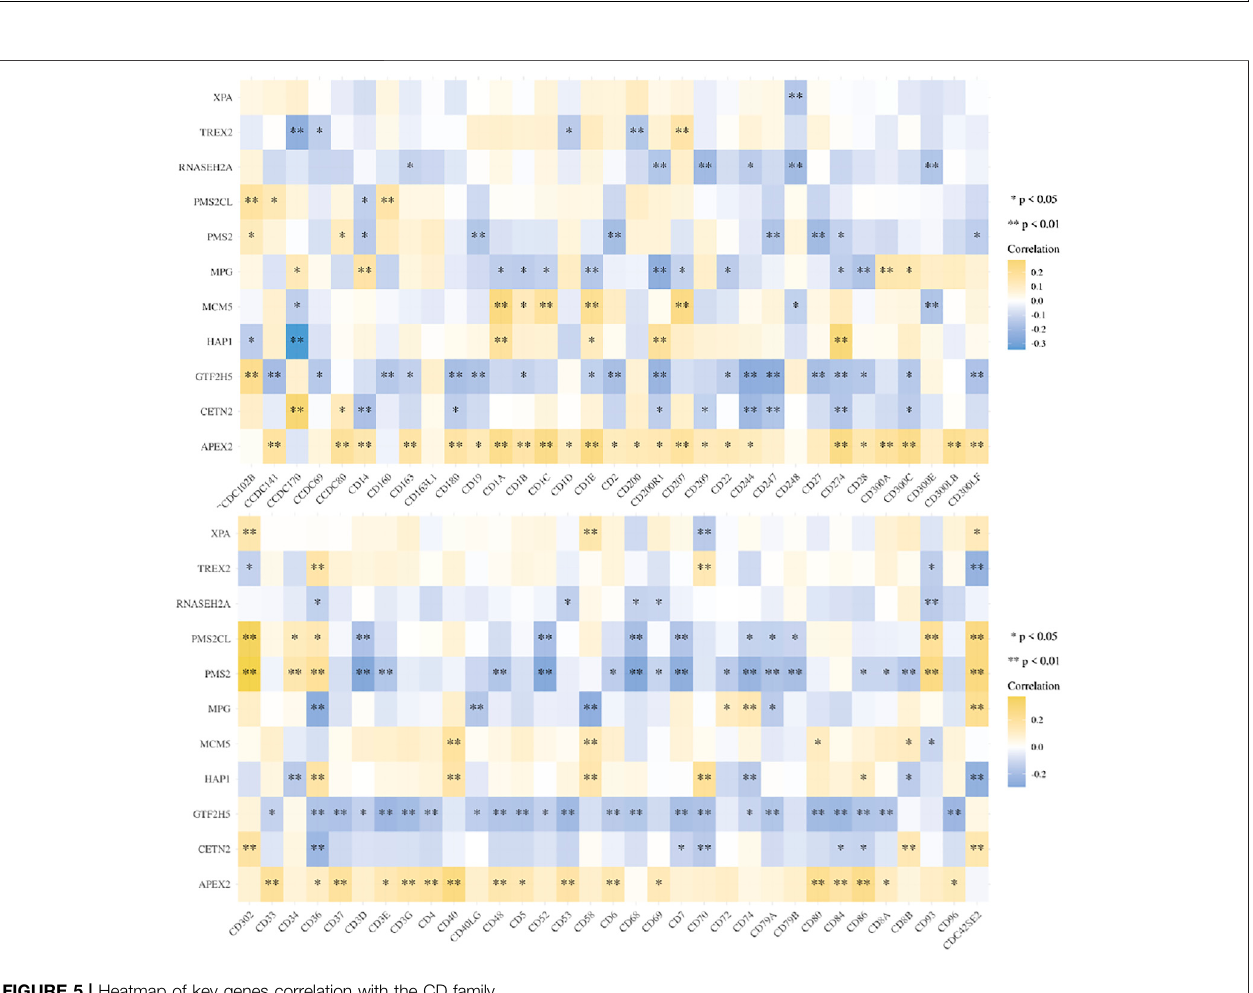
Frontiers in Genetics |